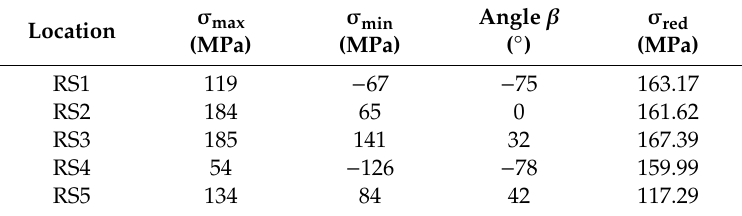
Table 4. Values and directions of residual stresses according to ASTM E